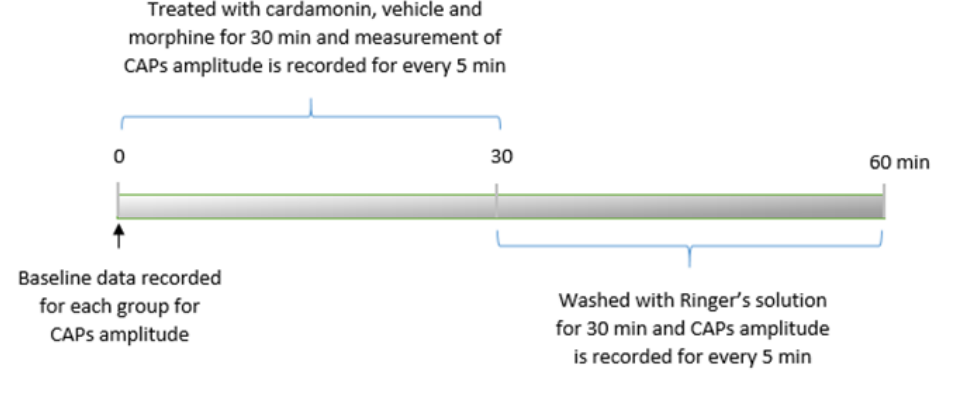
Figure 1: Protocol for the CAP inhibitory effects of cardamonin